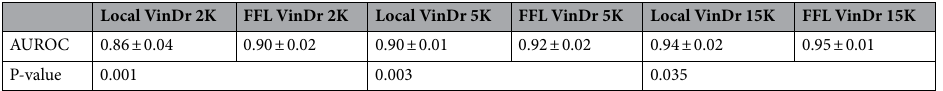
Table 1. Results of the comparison between local and FFL-based training of VinDr-CXR dataset with non- overlapping labels for different training set sizes, tested on the VinDr-CXR benchmark. Average area under the receiver-operator-curve (AUROC) over cardiomegaly and pleural effusion . The FFL was performed in combination with UKA-CXR dataset of n = 122,294 images with two different labels including pleural effusion right and pneumonic infiltrates